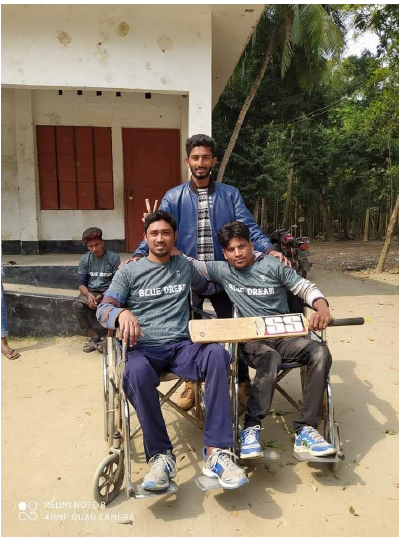
Figure 7. Alt-text: A man sitting on the floor, grinding spices and smiling, with his empty wheelchair behind him.